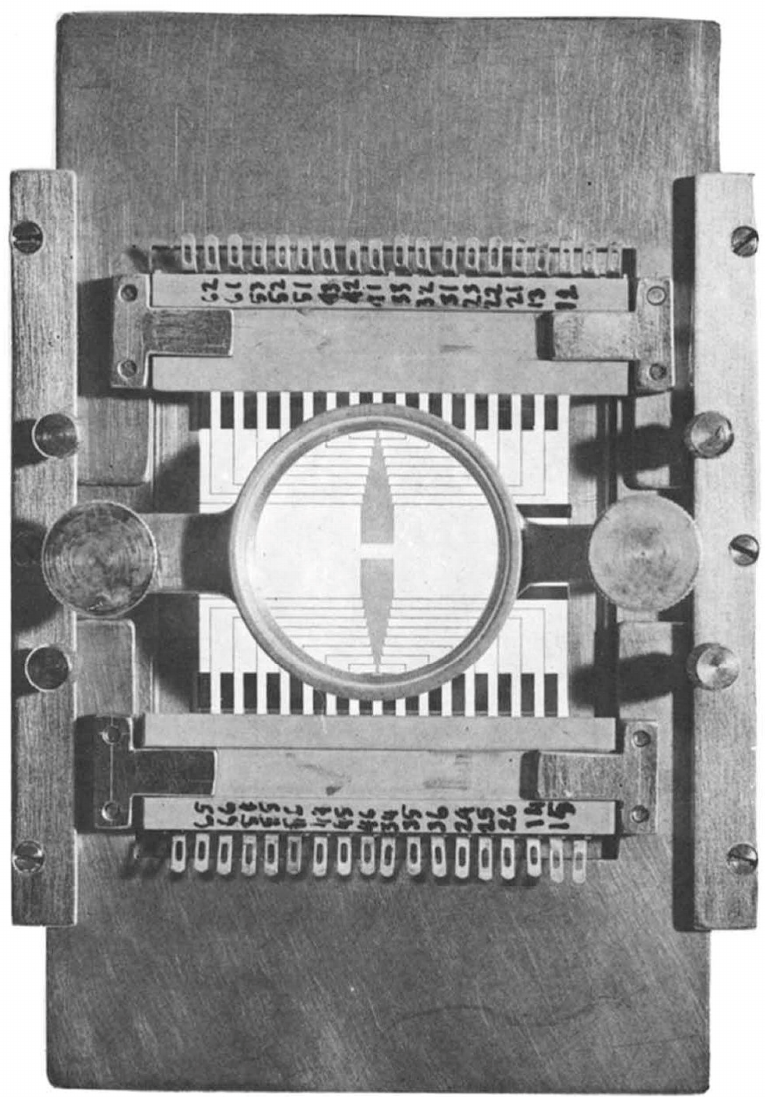
Figure 6. The microelectrode array consists of 36 photoetched microelectrodes with electrode holders, culture ring, and contact strips to study the single-unit neuronal activity. Reprinted with the permission of [81].